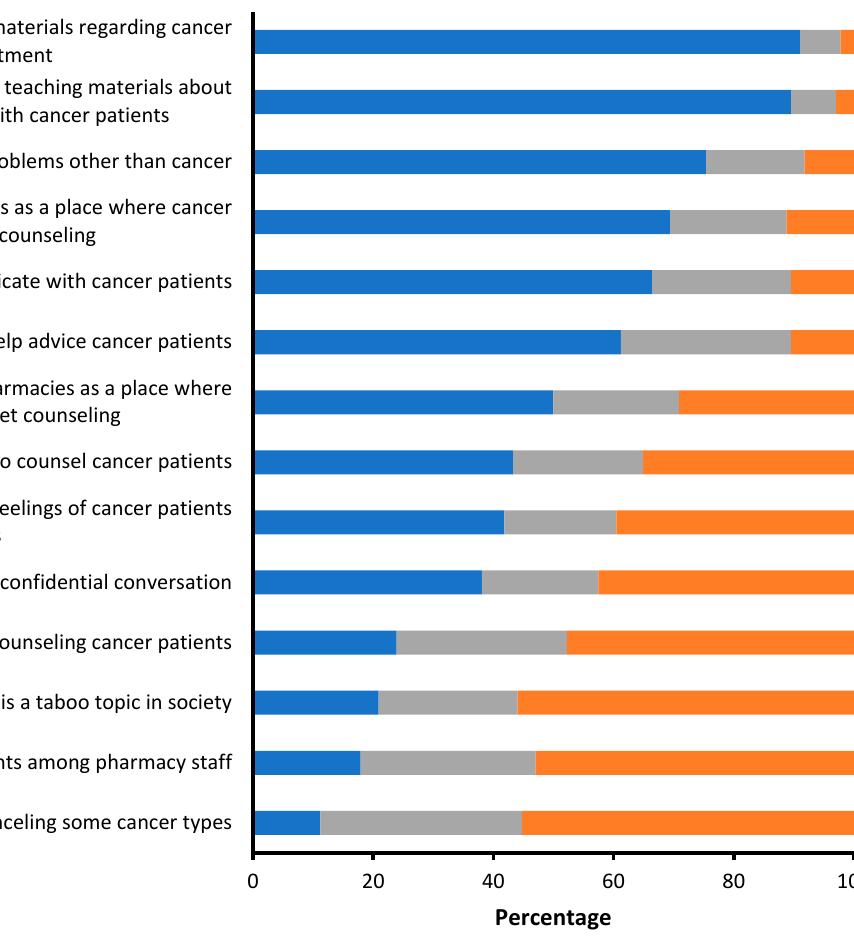
Figure 1. Potential barriers concerning counseling current or former cancer patients at a community pharmacy. Ratings are defined as: Agree and strongly agree. Neutral. Disagree and strongly disagree. (n = 134).